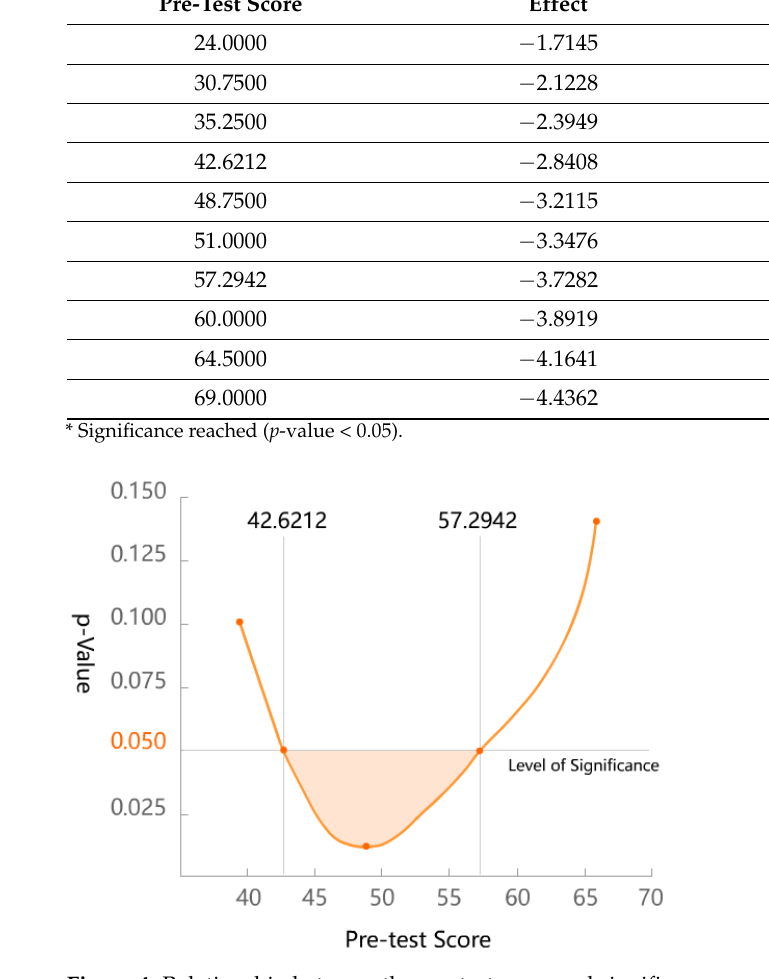
Table 11. Conditional effect of group on the post-test at values of the pre-test.